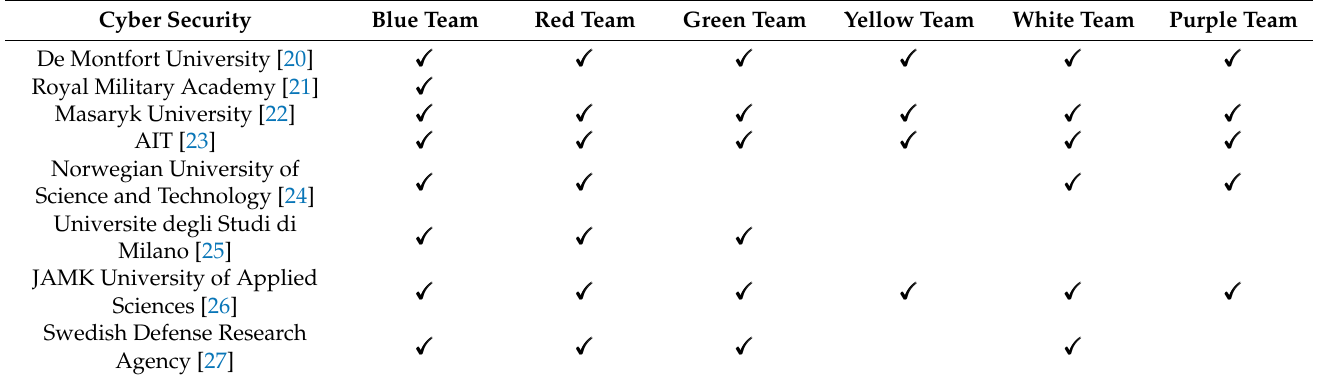
Table 1. The colors used by cyber exercise teams/roles, which identified intended users. Cyber Security Blue Team Red Team Green Team Yellow Team White Team Purple